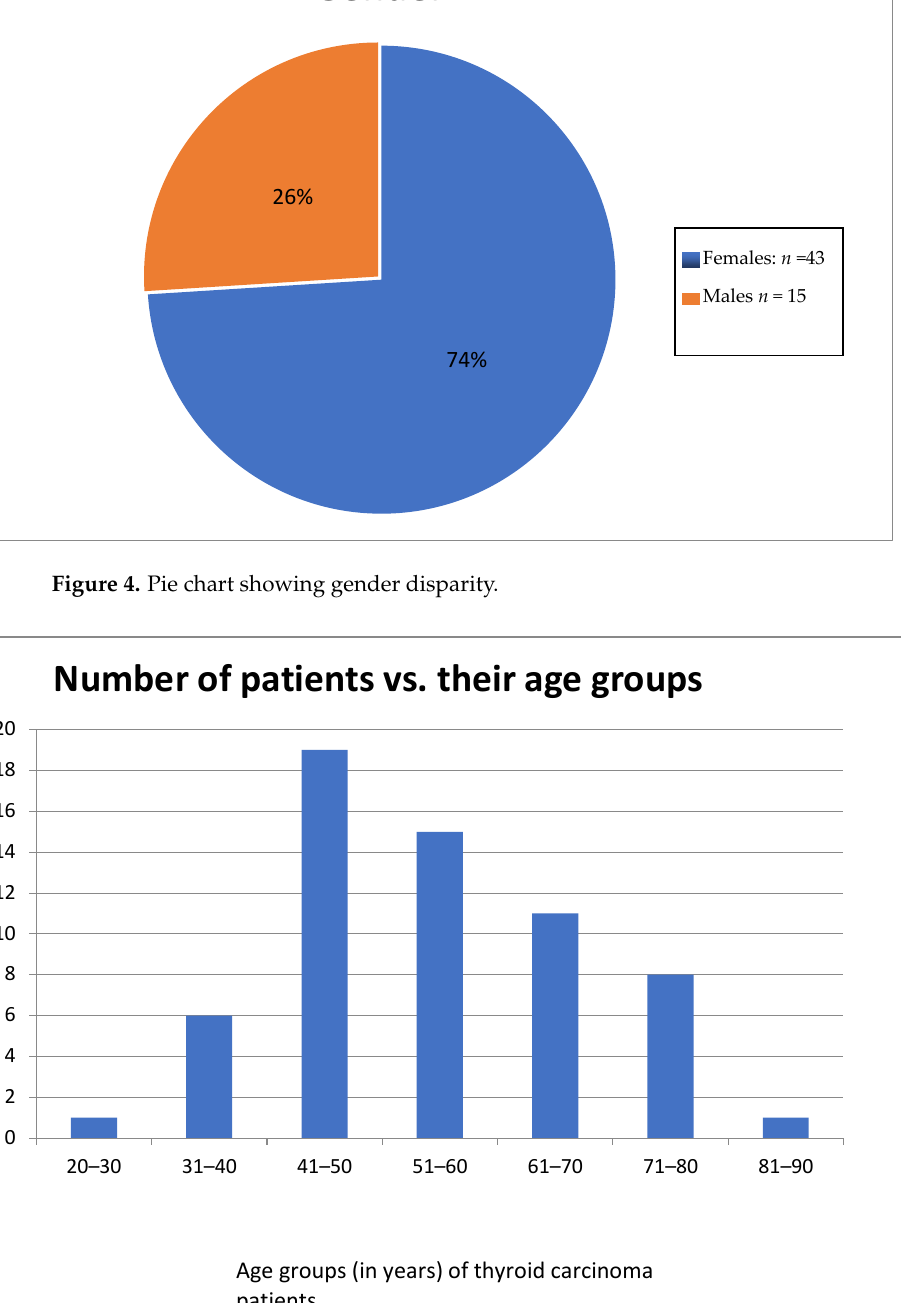
The number of female thyroid cancer patients was three times that of male